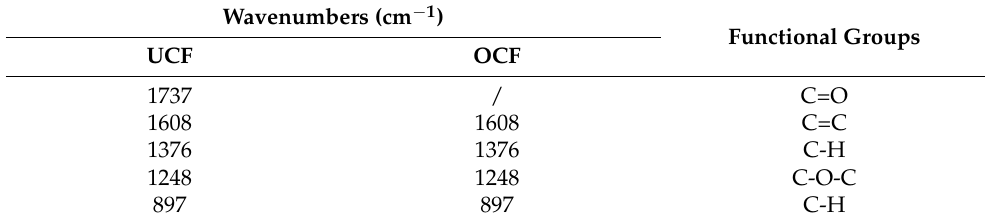
Figure 13. ( a ) FTIR spectra of untreated (black) and treated (red) coir fibers under optimal conditions. ( b ) Enlarged view of labeled regions in FTIR spectra. Table 7. Peak value of change in FTIR